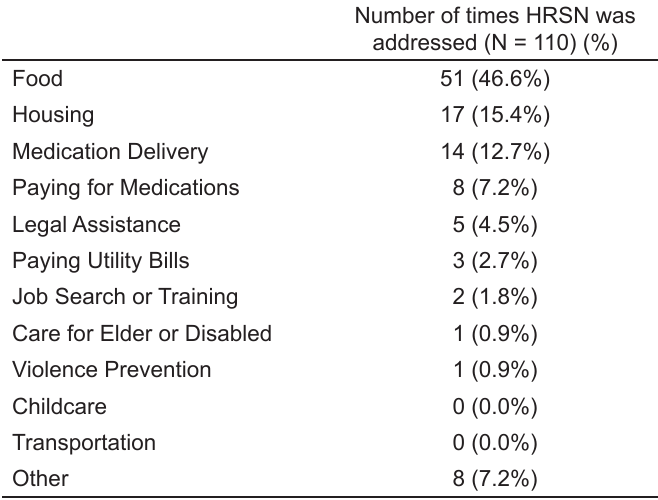
Table 5. Type of health-related social needs addressed by patient navigators in the emergency department.